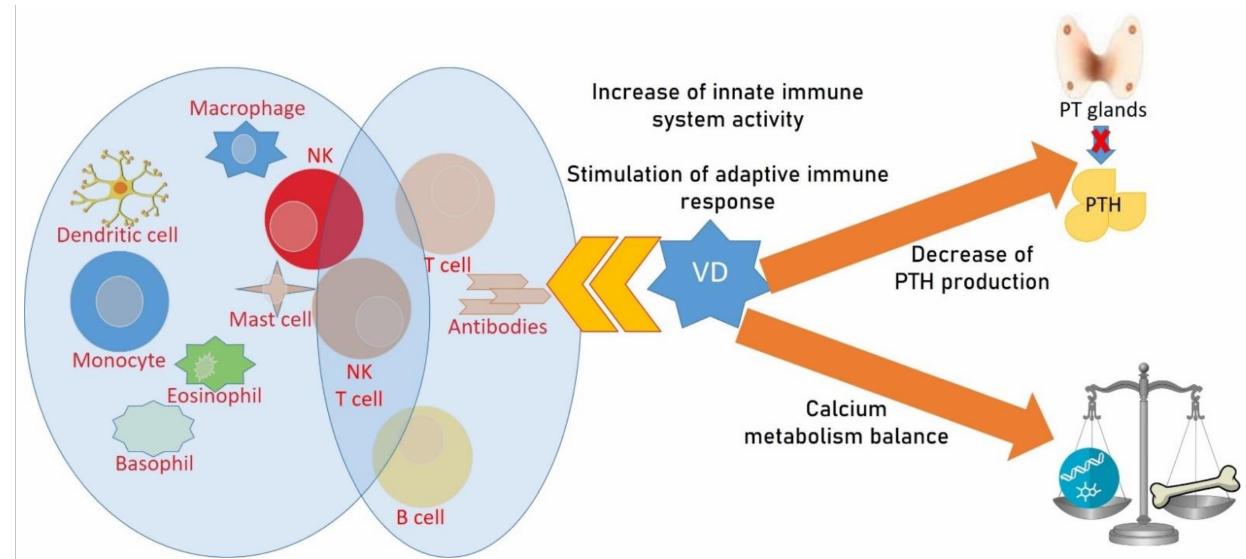
Figure 3. Vitamin D, bone modifications, and endocrinological diseases. VD can increase the activity of the innate immune system and stimulate the adaptive immune response, promoting immune tolerance and reducing the development of autoimmune